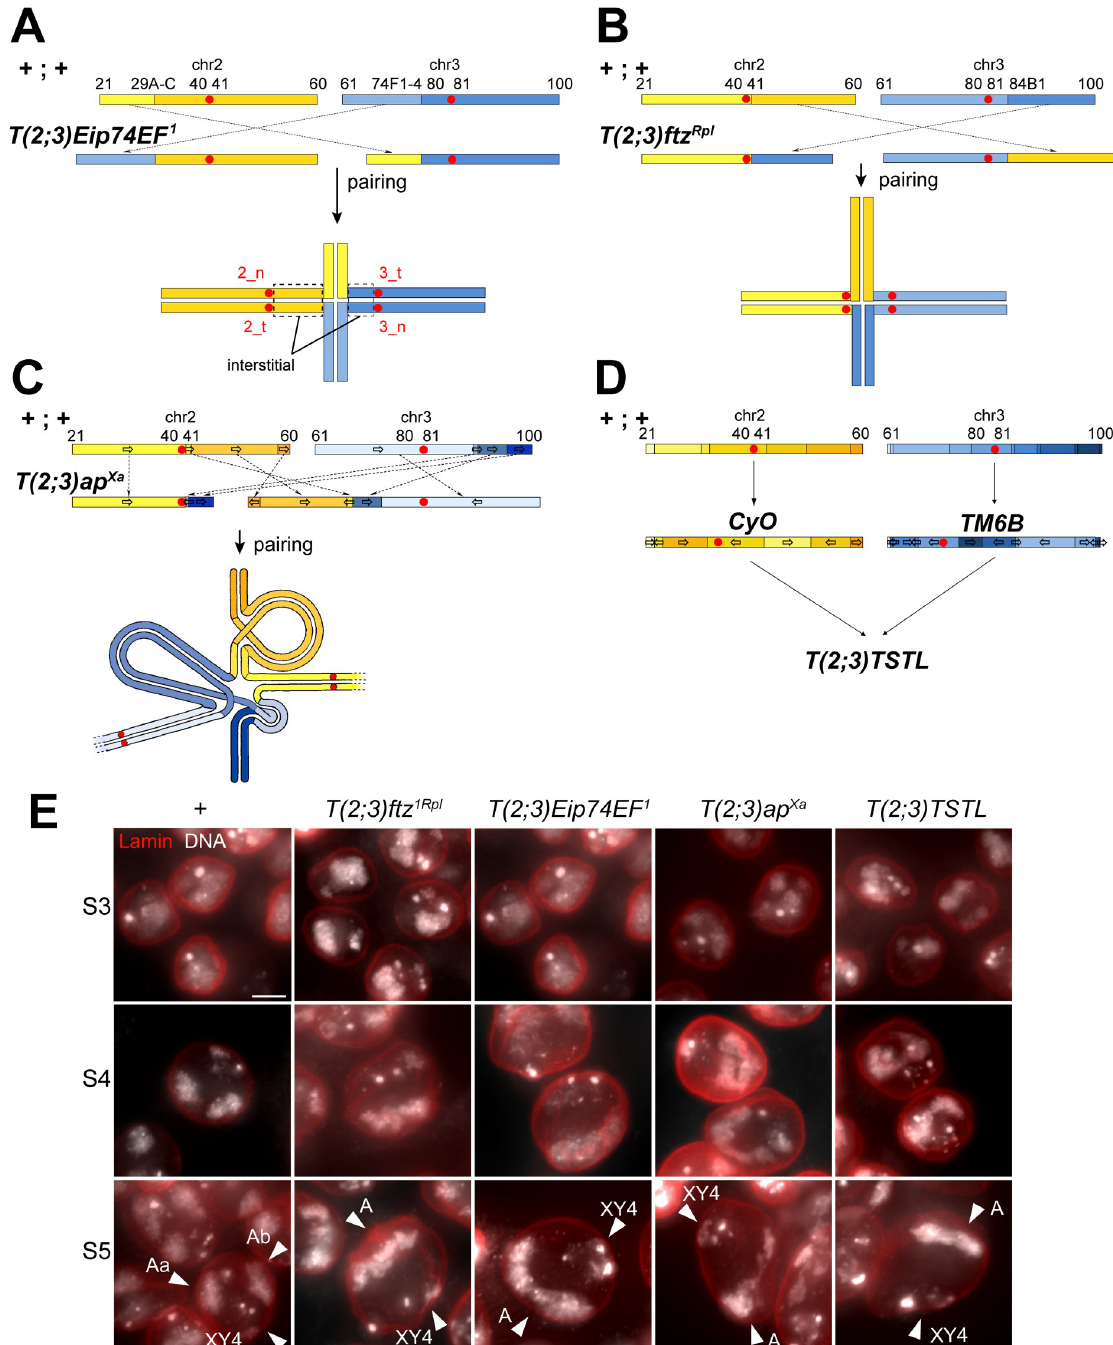
Fig 3. Chromosome territories in spermatocytes heterozygous for reciprocal T(2;3) translocations. ( A-D ) Structure of the analyzed reciprocal T(2;3) translocations and of the expected pairing into quadrivalents in heterozygous cells. Centromeres are indicated by red circles, and in (A) they are labeled in red type, indicating chromosome number (2 or 3) and presence on either normal (n) or translocation (t) chromosome. The regions between centromeres and translocation breakpoints are designated as interstitial segments. Note that pericentromeric heterochromatin has been omitted. The type I translocations, T(2;3)Eip74EF 1 (A) and T(2;3)ftz Rpl (B), have a single chromosomal translocation break point. In contrast, the type II translocations, T(2;3)ap Xa (C) and T(2;3)TSTL (D), have multiple chromosomal break points because the precursor chromosomes carried inversions. Pairing in case of type II translocation heterozygotes requires complex looping gas illustrated in (C) (adapted from [31]). ( E ) Squash preparations of testes from males, which were either wild- type (+) or heterozygous for the indicated T(2;3) translocations, were labeled with anti-Lamin Dm0 and a DNA stain. As illustrated